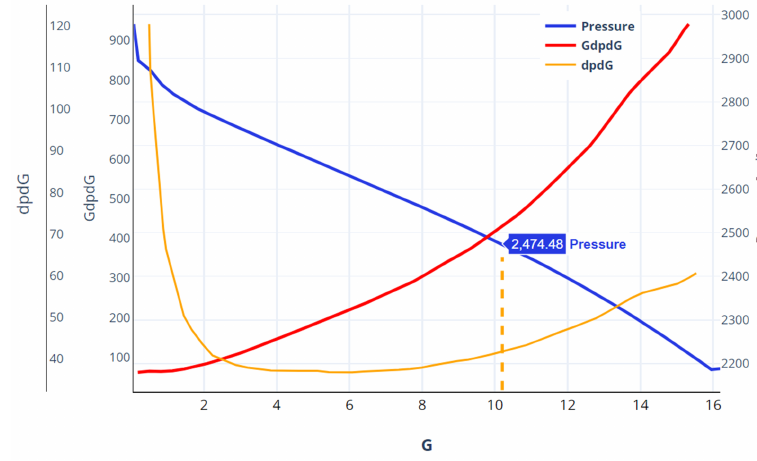
Figure 23. Analysis of test 4 cycle 4 using tangent and compliance methods.